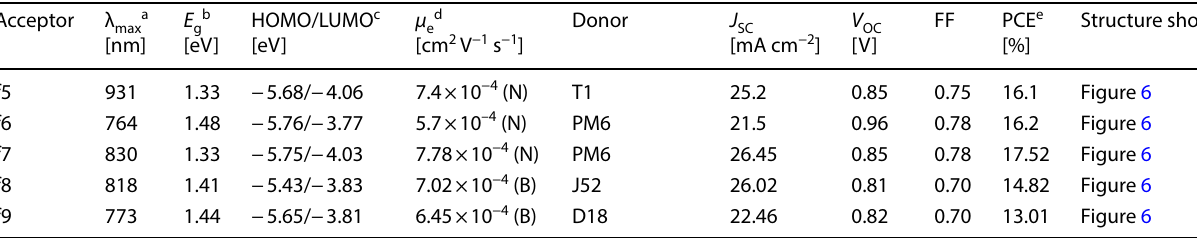
c Estimated from the cyclic voltammetry data or LUMO = HOMO + E gb d Measured by SCLC method in neat (N) or blend (B)